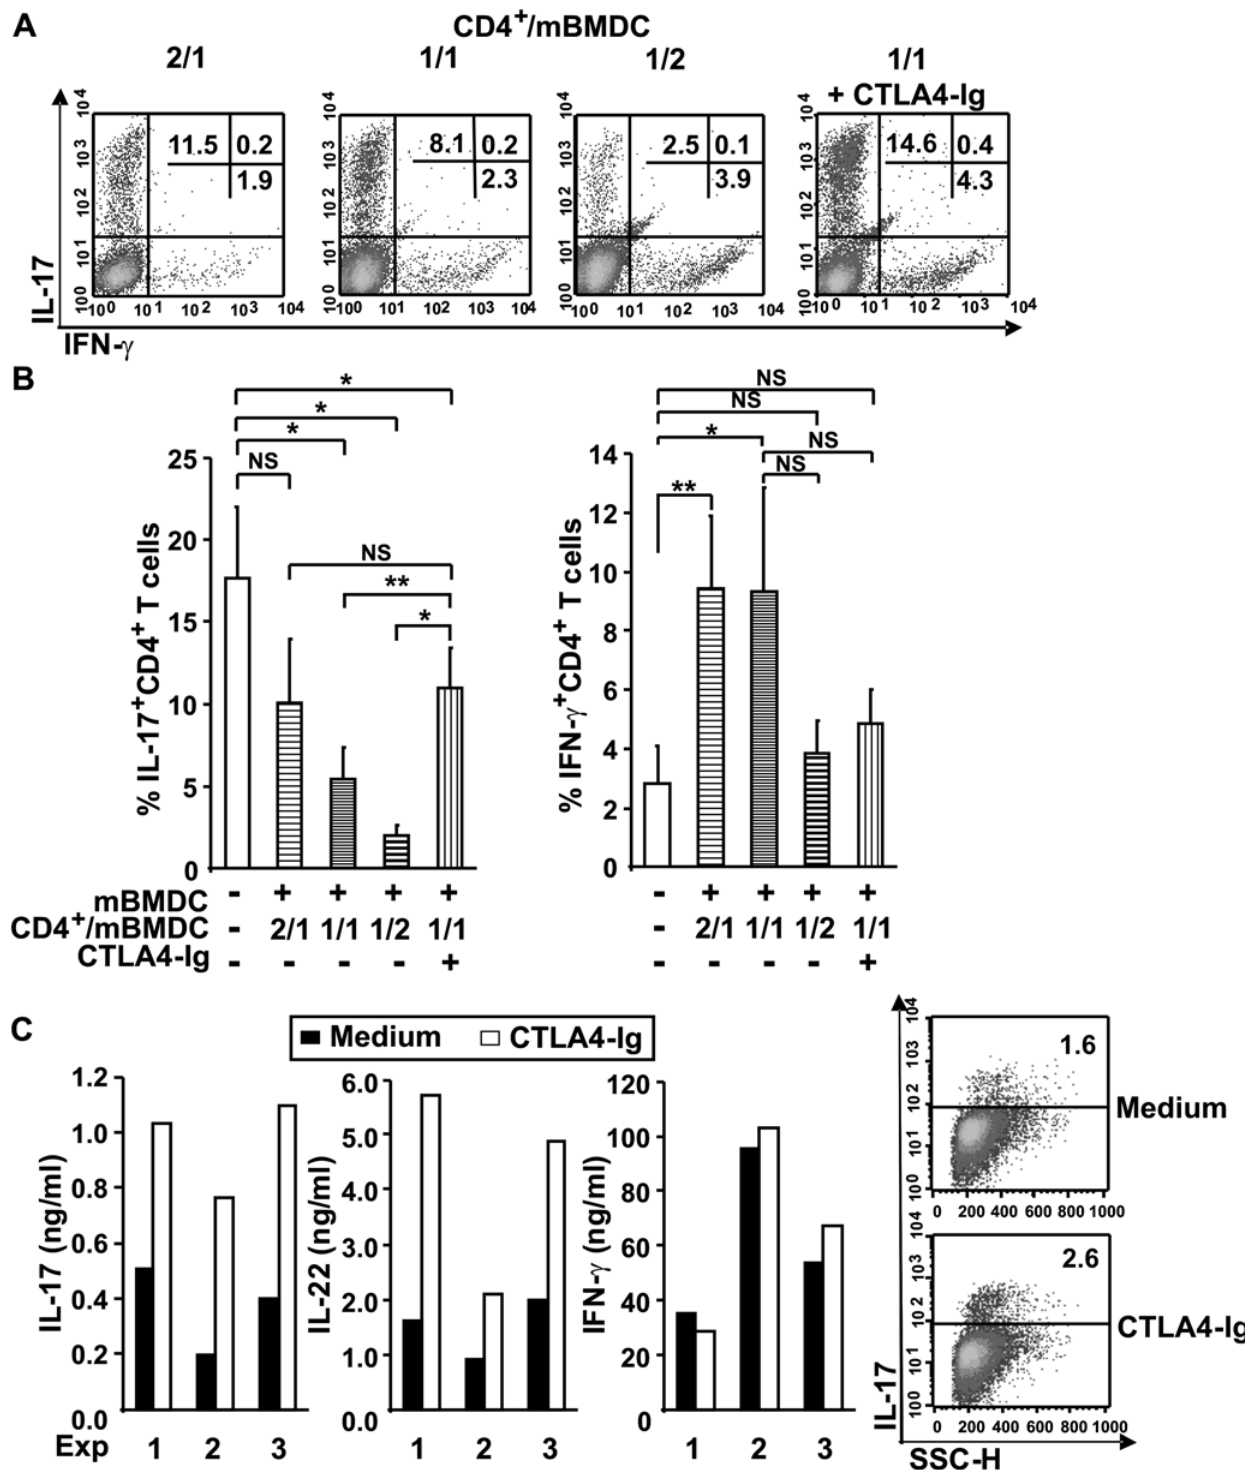
Figure 7. CTLA4-Ig favours Th17 development. (A) CD4 + T cells were cultured with mature BMDC at three different CD4 + /mBMDC ratios (2/1; 1/ 1; 1/2) in the presence of anti-CD3 under Th17 conditions. CTLA4-Ig (20 m g/ml) was added to cultures with a 1/1 CD4 + /mBMDC cell ratio. Cells were stained intracellularly for IL-17 and IFN- c . Shown is one representative experiment out of 4. (B) CD4 + T cells were stimulated as in A. Data represent the mean 6 SD of 4 experiments. (C) Human naı¨ve CD4 + T cells were co-cultured with activated monocyte-derived DC in the presence or absence of CTLA4-Ig (5 m g/ml), expanded in IL-2 and restimulated. IL-17, IL-22 and IFN- c secretion was assessed in the culture supernatants and cells were stained for intracellular IL-17. Shown are 3 independent experiments (ELISA, left panel) and 1 representative out of 3 experiments (intracytoplasmic staining, right panel). P values were calculated using the two-tailed, paired Student’s t test, *, P , 0.05; **, P , 0.01.